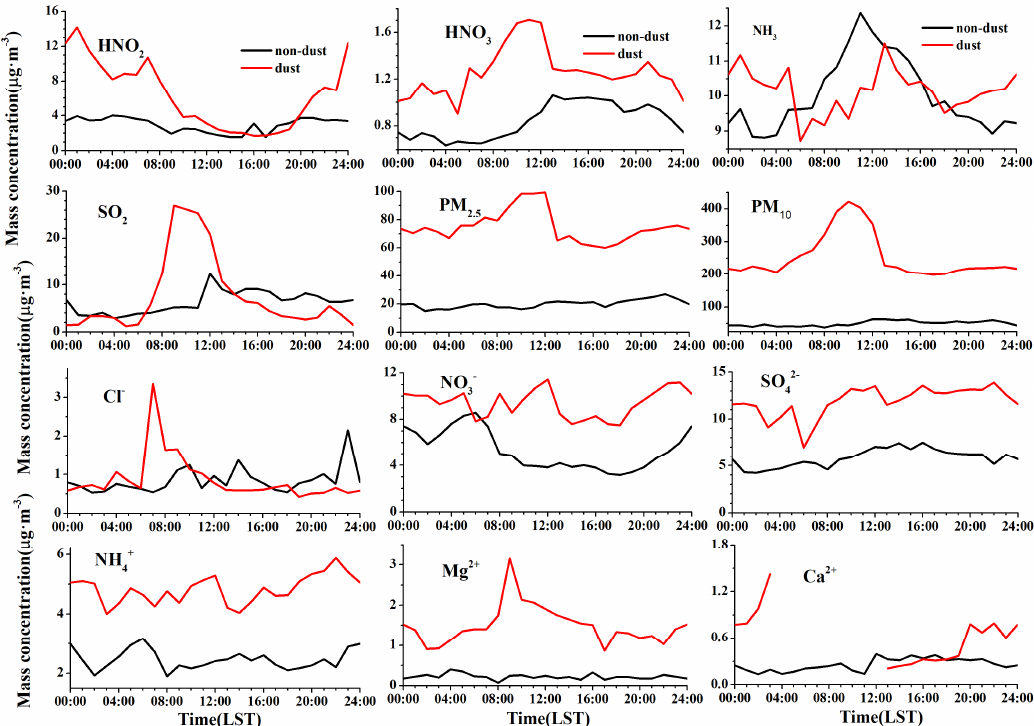
Atmosphere 2019 , 10 , 68 Figure 3. Diurnal variations of chemical components during the dust and non-dust episodes.